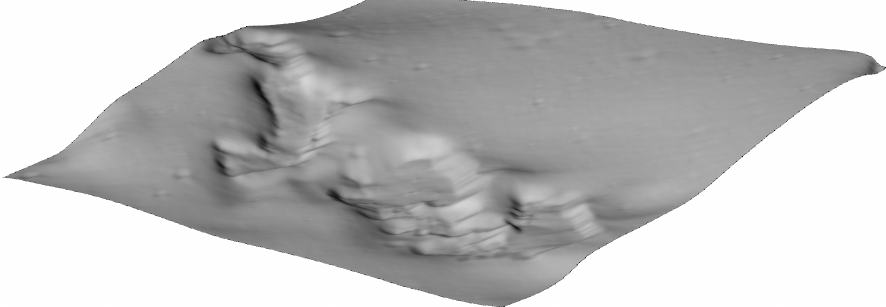
Figure A3. Rendered SfS